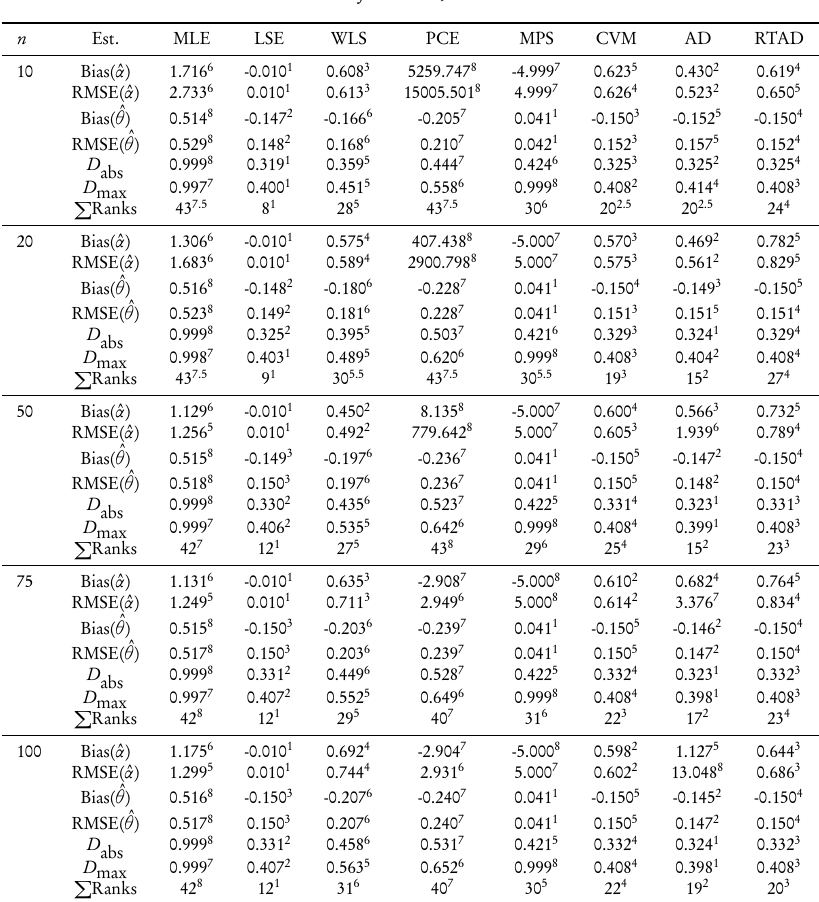
Simulation results for α = 5 , θ = 0.3 and λ = 1